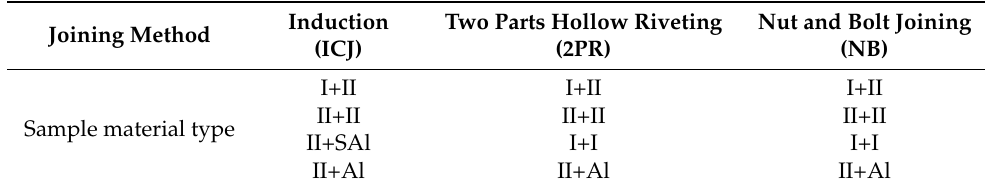
Figure 4. Joining samples of Type I and Type II for the three joining methods. NB: nut and bolt; 2PR: two-piece hollow riveting. Table 1. Material type and joining method applied in the experiments.